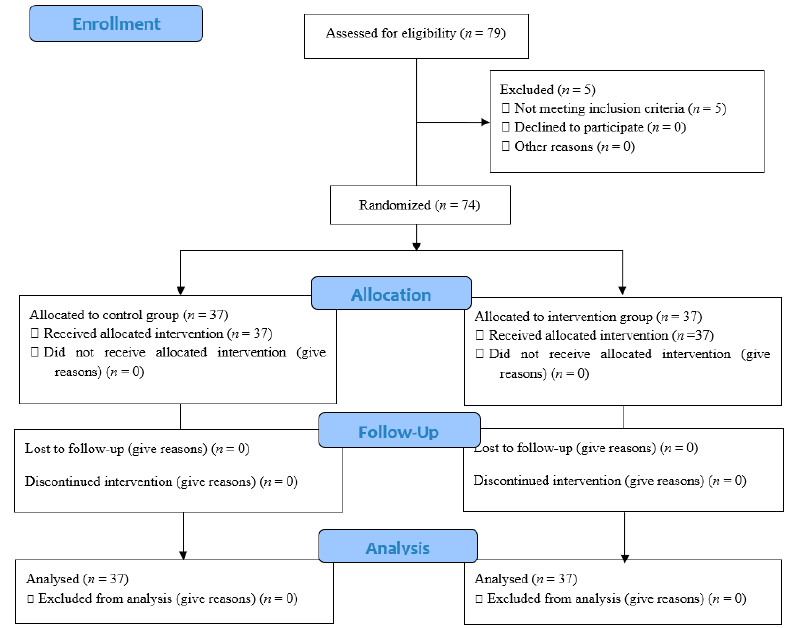
Figure 1. The process of the study according to the CONSORT flow diagram.